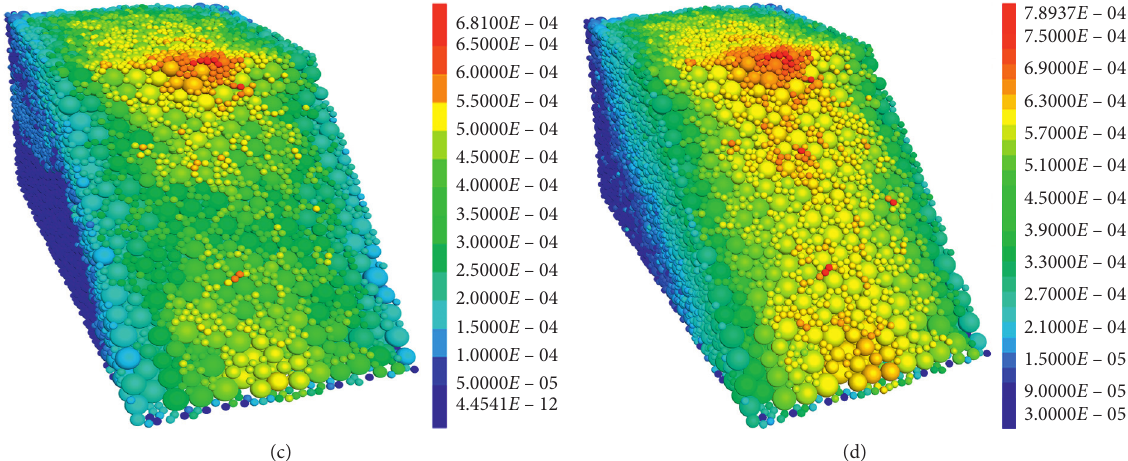
Figure 12: Slope displacement fields under different frozen depths. (a) 10%, (b) 20%, (c) 40%, and (d) 100% (unit: m).